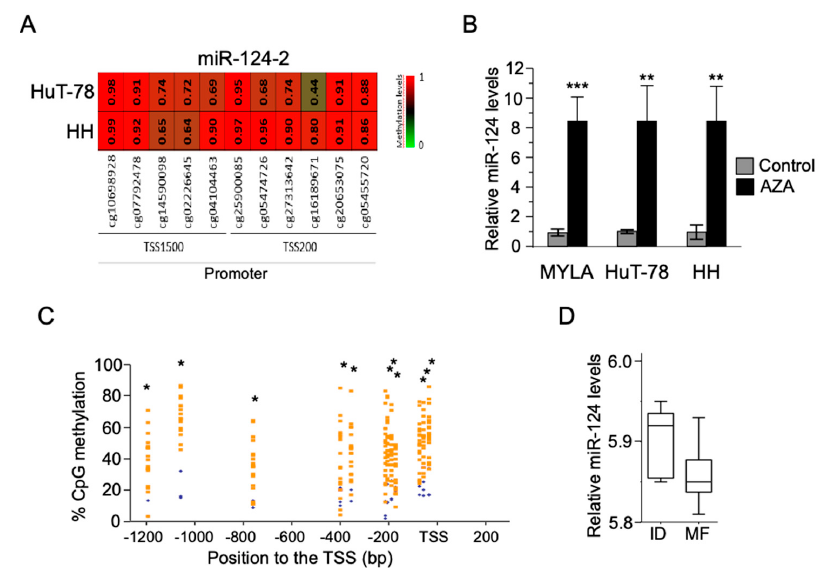
Figure 1. Hypermethylation and silencing of miR-124 in CTCL cell lines and MF tumor samples ( A ) DNA methylation levels of consecutive promoter CpGs from miR-124 in CTCL cell lines analyzed by the 450K DNA methylation microarray. Gradient color bar reference means Green (0, minimum) unmethylated, Red (1, maximum) hypermethylated; ( B ) restored expression of DNA methylated miR-124 in CTCL cell lines after treatment with the DNA demethylating agent 5-aza-2 ′ -deoxycytidine. qRT–PCR product concentration (Ct) value for U6 was used to normalize overexpression of miR-124 in CTCL cell lines by the method ΔΔ Ct ( ΔΔ Ct = Δ Ct sample of interest— Δ Ct reference sample) *** p < 0.001, ** p < 0.01; ( C ) Differentially methylated CpGs in miR-124 were identified in the comparison between MFt (orange) and inflammatory dermatoses (ID) (blue). * p < 0.05; ( D ) downregulation of miR-124 expression associated with its promoter hypermethylation in MFt samples. miR-124 expression showed lower levels in MFt samples respect to ID controls. Mann Whitney test, p -value = 0.0714, trend p < 0.01; t test, p -value = 0.0449 (statistical significance was reached when outliers were not considered).